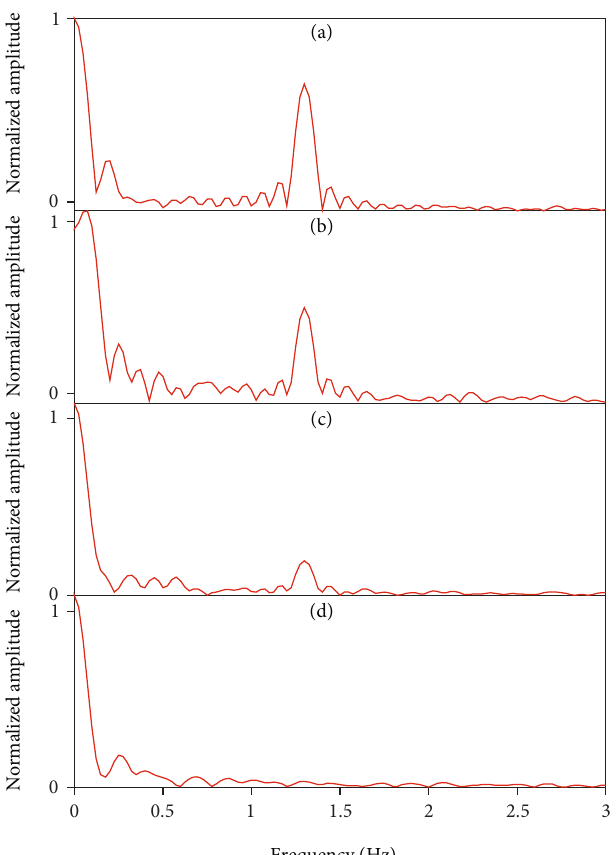
Figure 4: The demodulation result in frequency domain for simulated signal with di ff erent SNR: (a) SNR = 13dB , (b) SNR = 10dB , (c) SNR = 7 dB , and (d) SNR = 5 dB .